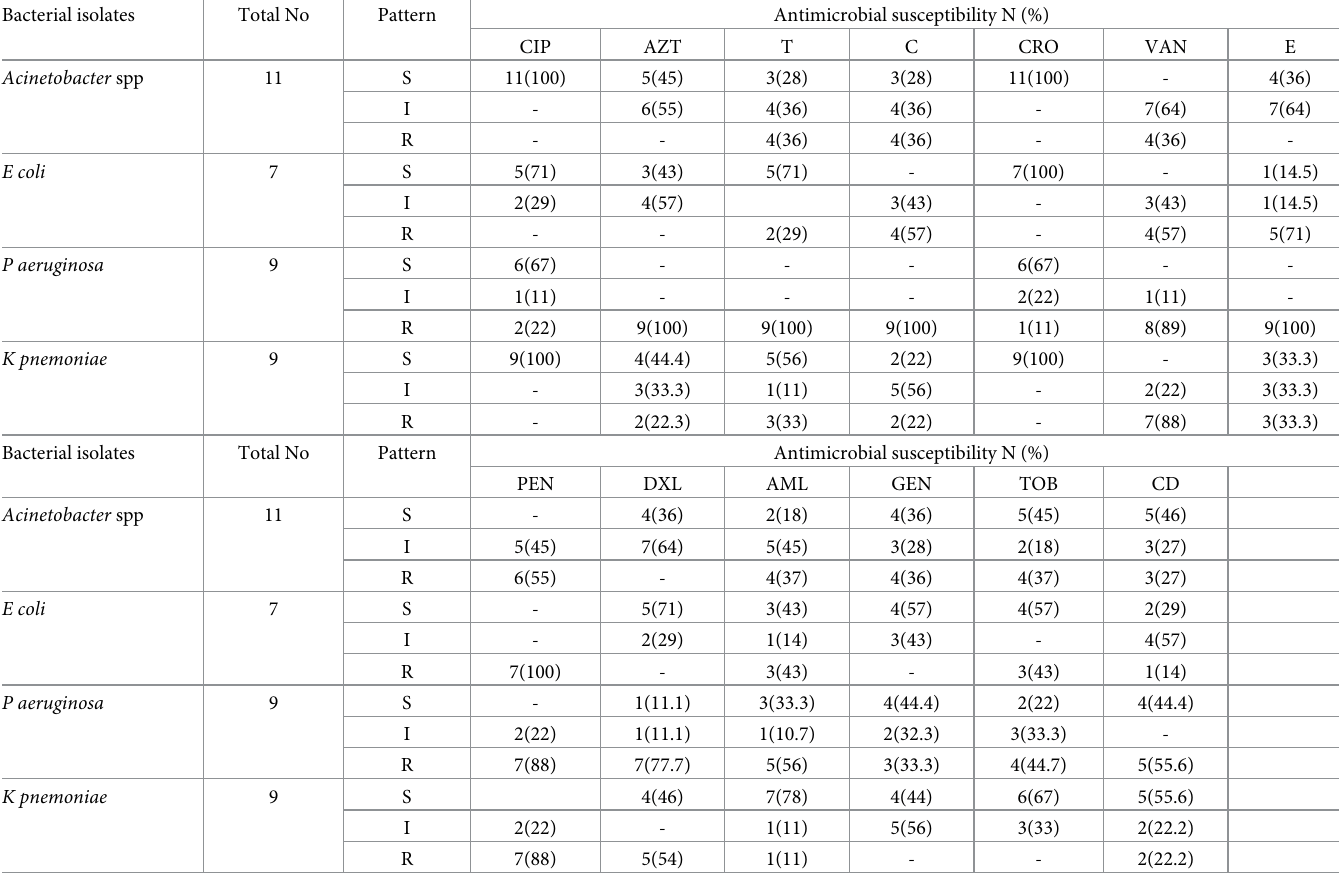
Table 5. Antimicrobial susceptibility pattern of gram-negative isolated bacteria from dental caries patients attended at Hiwot Fana comprehensive specialized uni- versity hospital, Harar, Eastern Ethiopia from April to June 2021. Bacterial isolates Total No